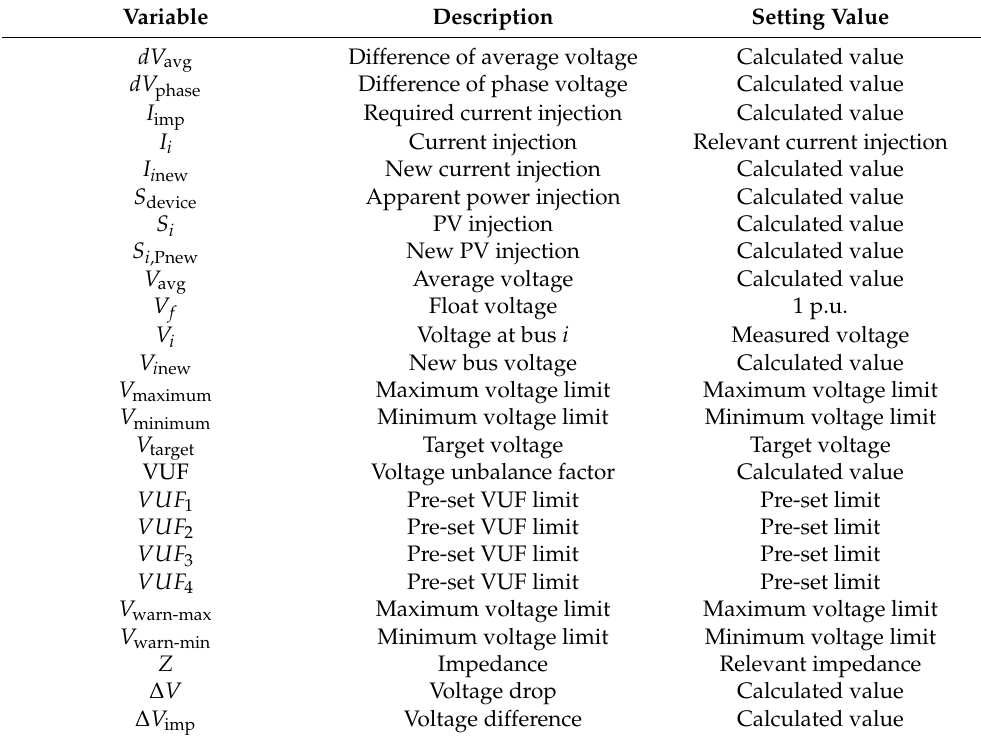
Table A1. Summary of